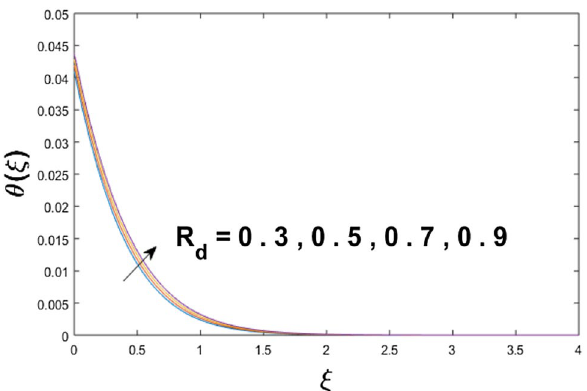
Figure 9. Variations of R d to θ(ξ) .